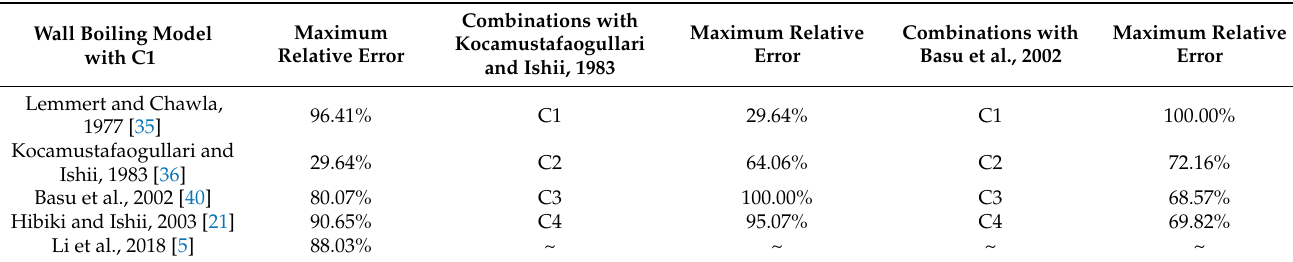
Table 9. Maximum relative errors between numerical results of α with DEBORA-1 experiment data ( P = 2.62 MPa) for first loop of NPP ( P = 15.70 MPa).